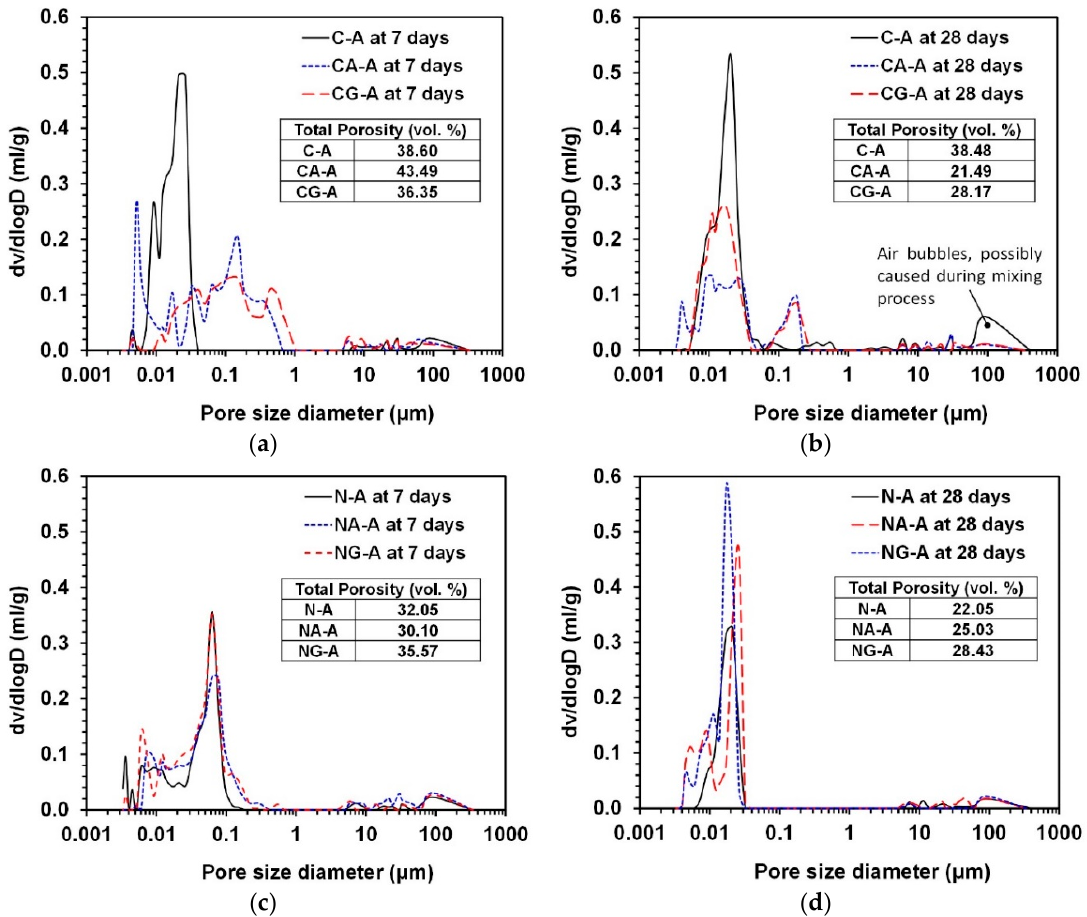
Figure 6. Pore size distributions from MIP: ( a ) effect of calcium sulfate type under CaO ‐ activation, ( b ) effect of calcium sulfate type under NaOH ‐ activation, ( c ) effect of activator type without calcium sulfates, ( d ) effect of activator type with anhydrite, and ( e ) effect of activator type with gypsum.